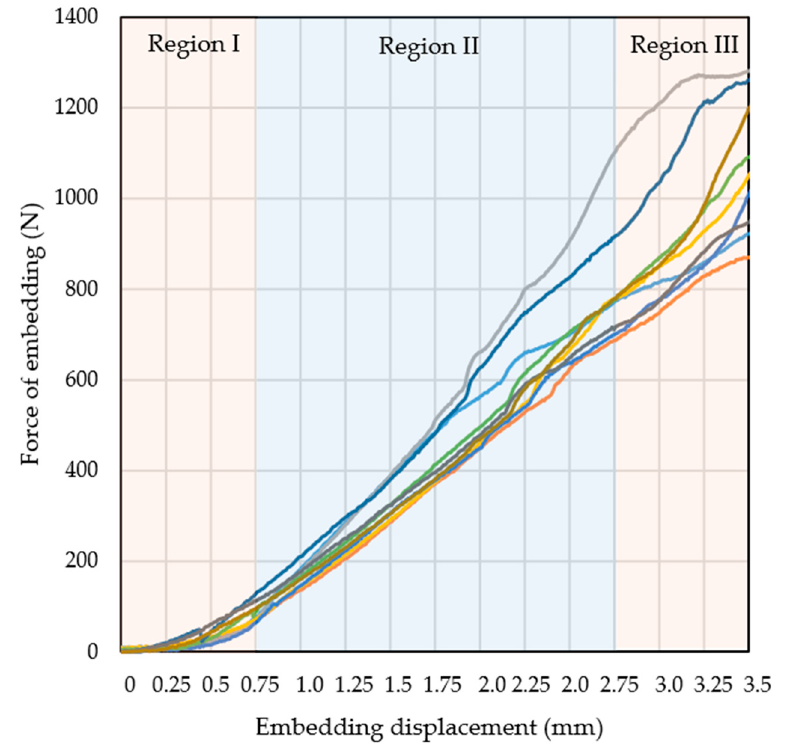
Figure 8. The embedding force-distance curves for 10 representative tests of the MSC-Scaffold prototype embedding in the periarticular bone.